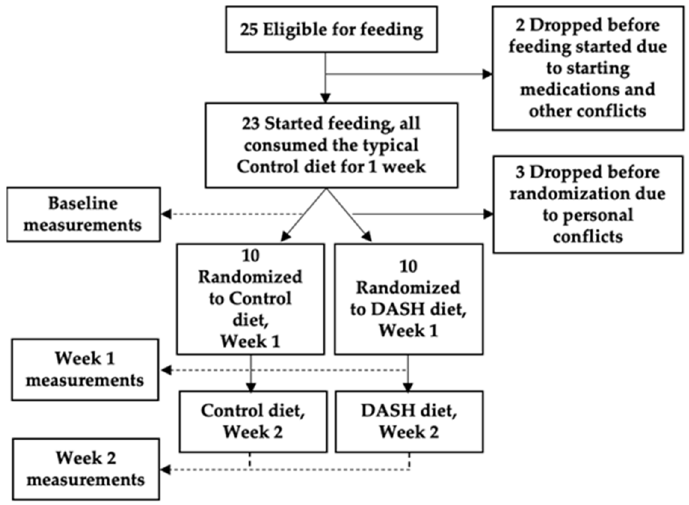
Figure 1. Study flow chart. Adapted from original published manuscript [6].